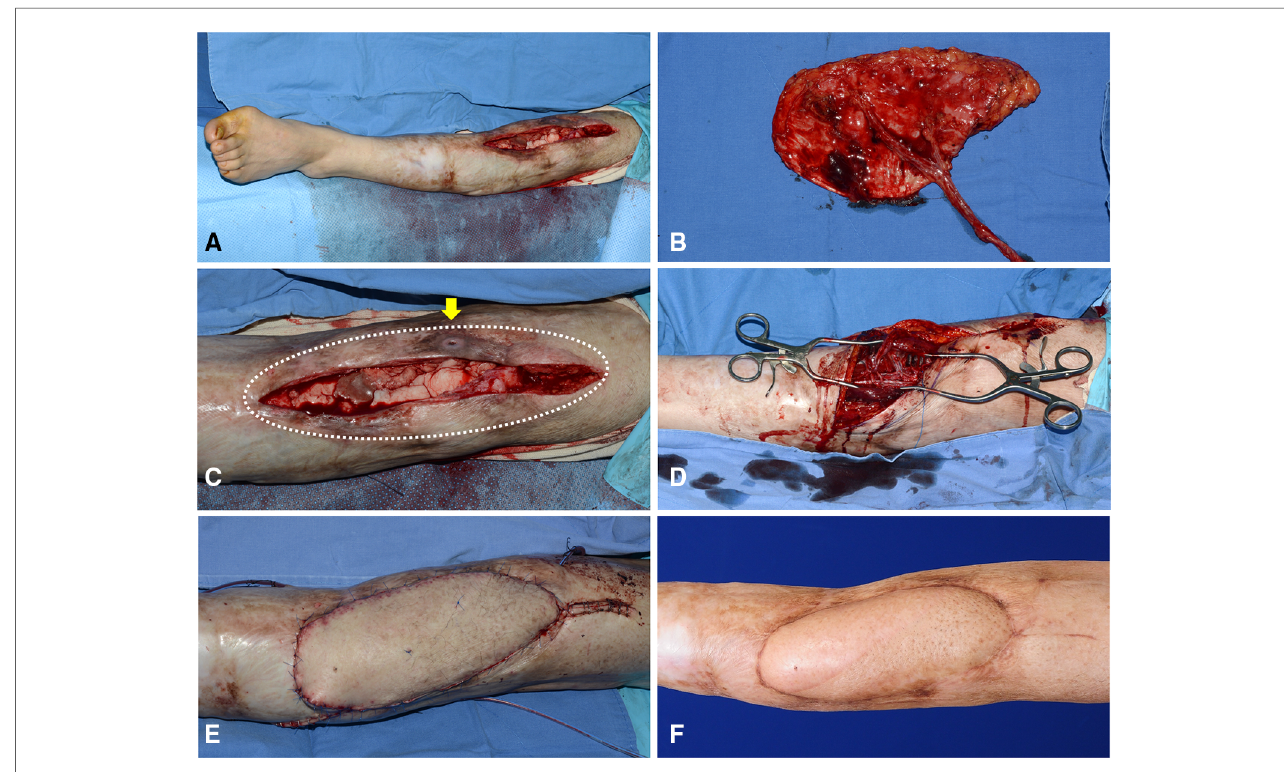
FIGURE 9 A clinical case presenting the reconstruction of the soft-tissue defect around the knee using Cen-ALTP fl ap, which is anastomosed to ATA and its venae comitantes (Case No.6; Algorithmic option No.4) ( A ) A wide soft-tissue defect was created by radical debridement in a 50-year-old male patient with chronic osteomyelitis. ( B ) Because the defect size was relatively large, Cen-ALTP fl ap with large long skin paddle (21×10 cm 2 ) was harvested. ( C ) The wide damaged soft tissues (White dotted line), including the sinus tract, which communicates between underlying infected bones and skin (Yellow arrow), was excised. ( D ) The fl ap pedicle was anastomosed to ATA and its concomitant veins. ( E ) Immediate postoperative photography showed that a healthy free ALTP fl ap replaced previous unhealthy soft tissues overlying knee osteomyelitis. ( F ) Result 6 months postoperatively. (ALTP, anterolateral thigh perforator; Cen-ALTP fl ap, ALTP fl ap with centrally located perforators; ATA, anterior tibial